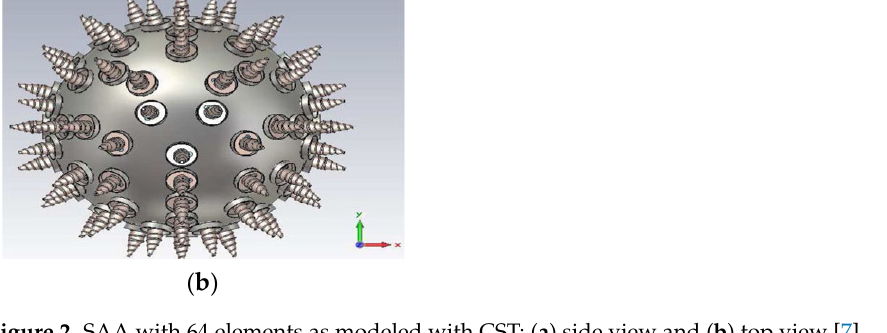
Figure 2. SAA with 64 elements as modeled with CST: ( a ) side view and ( b ) top view [7].